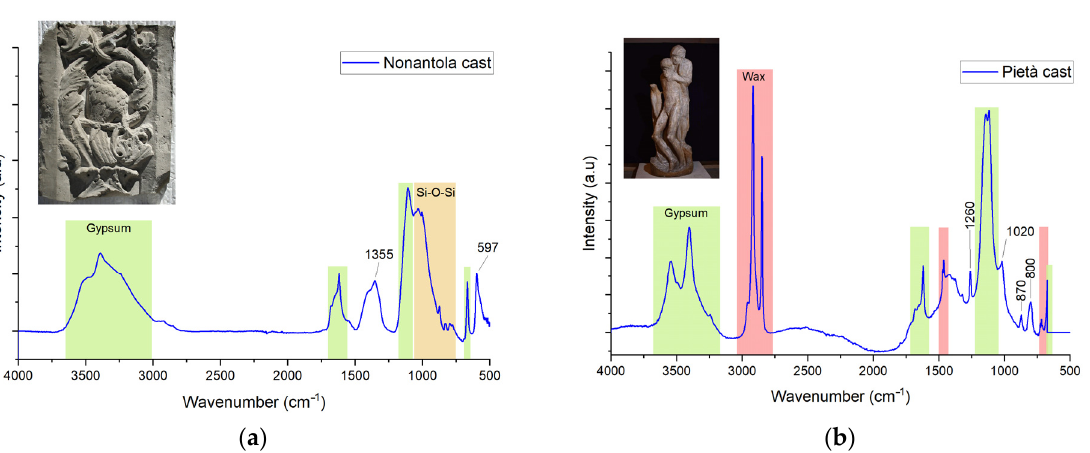
Figure 10. FTIR spectra of ( a ) atmospheric soiling on gypsum from cast of Nonantola Abbey and ( b ) wax over gypsum of the cast of the Pietà Rondanini.